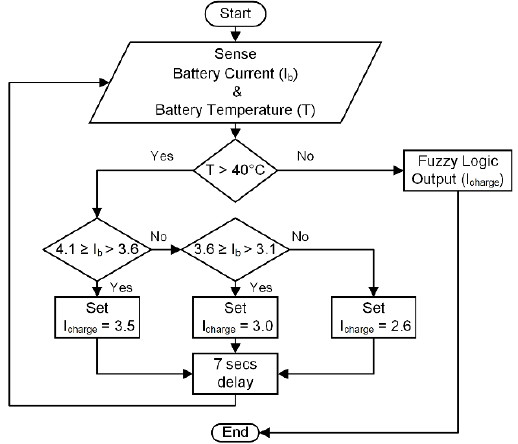
Figure 5. Temperature control flow chart.